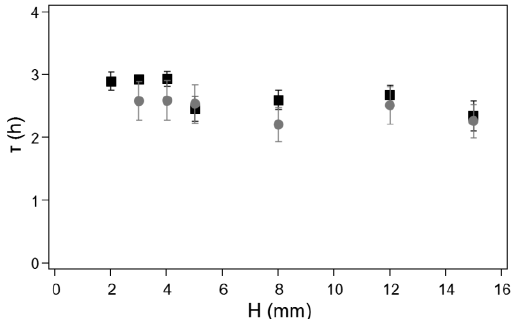
Fig. 7. Characteristic time τ as a function of the aperture of cell H obtained by equation (4) ■ individual growth experiments, ● collective experiments growth. The bars represent the dispersion of τ for each experiment